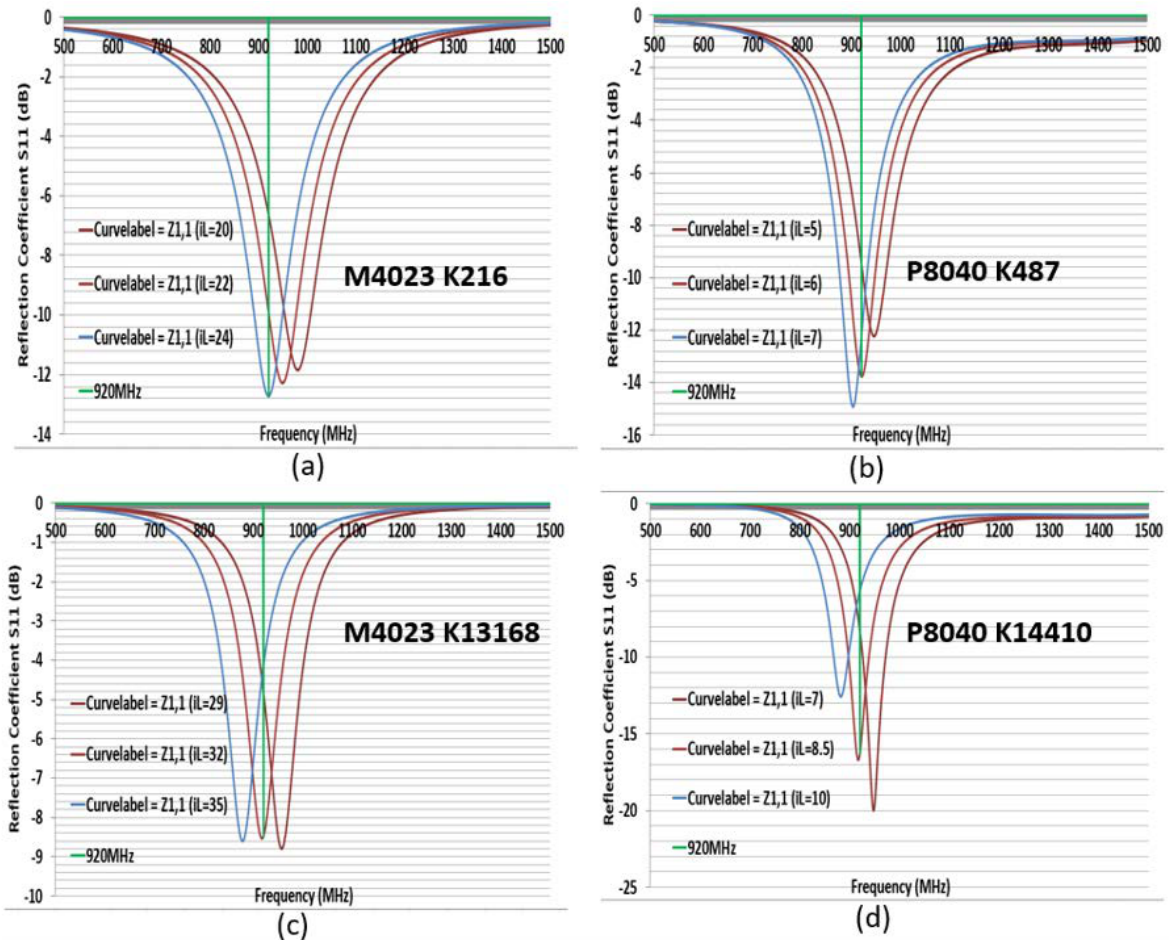
Figure 7. Comparison of S11 for tuned CFTA M4023 and P8040 using different K values. M4023 with K216 is matched with the tag for a reflection coefficient S11 = − 12.7 dB, L = 40, W = 23, gap = 2, iW = 4, iL = 24 mm and the impedance Za = 43 + j196 Ω . M4023 with K13168 is matched with a tag for a reflection S11 = − 8.5 dB, L = 40, W = 23, gap =